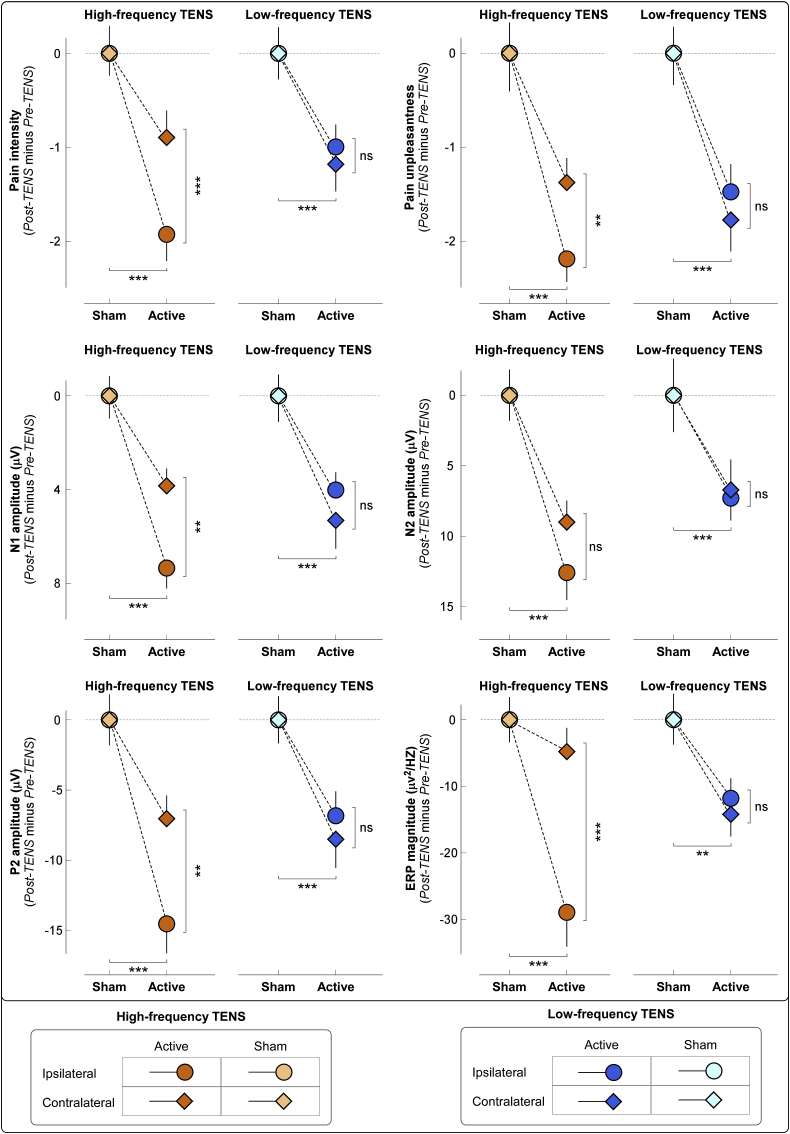
Effects of different TENS type on laser-elicited pain perception and brain responses. Effects of TENS on laser-evoked pain intensity and unpleasantness (top plots) and brain responses (middle and bottom plots) are evaluated as difference between Pre-TENS and Post-TENS sessions (Post-TENS minus Pre-TENS, normalized by subtracting the respective sham data for displaying purpose; statistical results from non-normalized data are reported in the main text). For both TENS types, the decrease of laser-elicited pain perception and brain responses was significantly larger in the active condition than that in the sham condition. High-frequency TENS induced a larger decrease of both pain perception and brain responses when laser stimuli were delivered to the hand ipsilateral to the TENS side than that contralateral to the TENS side (*: p ​< ​0.05; **: p ​< ​0.01; ***: p ​< ​0.001). In contrast, the decrease in pain perception and brain responses induced by low-frequency TENS was similar when laser stimuli were delivered to the hand ipsilateral and contralateral to the TENS side (ns: not significant). Data are mean ​± ​SEM.